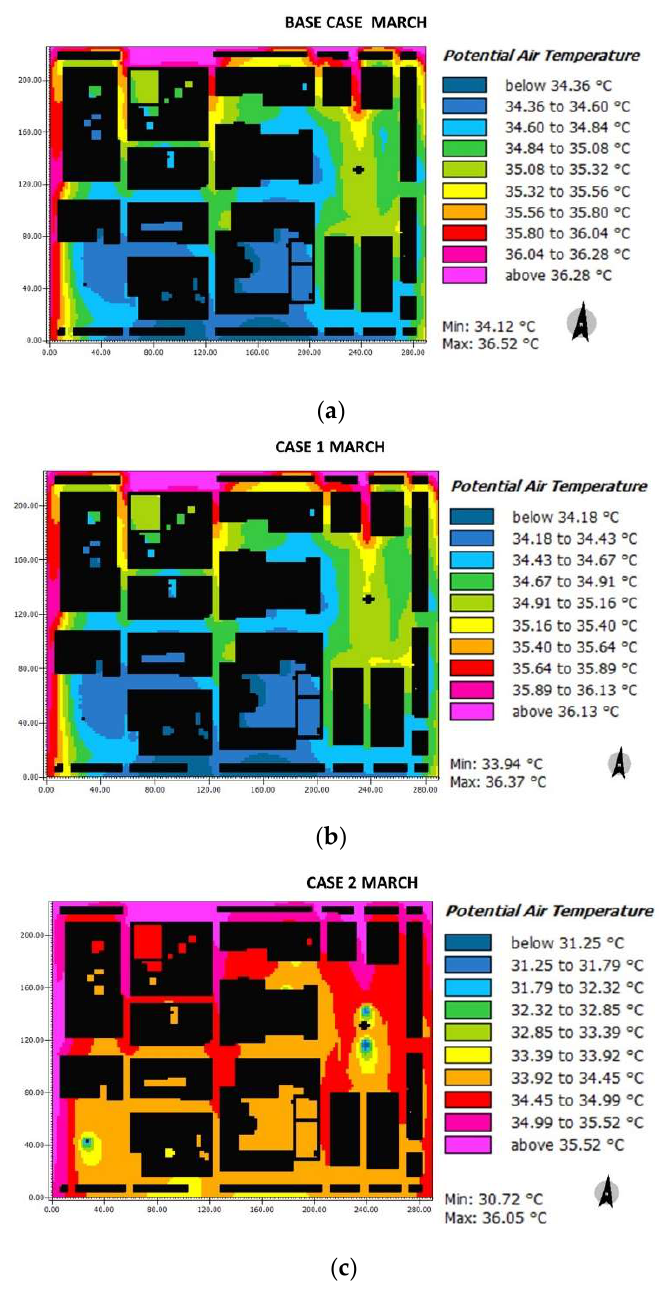
Figure 11. Results maps for potential air temperature for March at 15:00: ( a ) base case, ( b ) case 1, and ( c ) case 2.